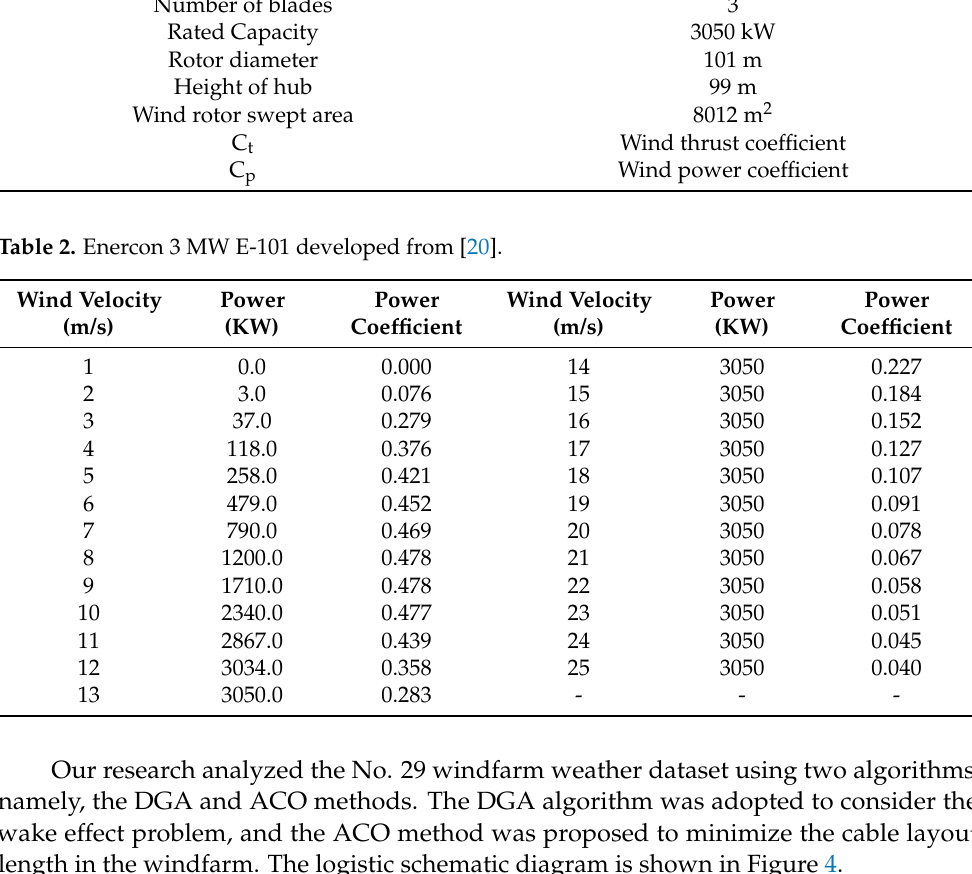
Table 1. Enercon E-101 3 MW unit parameters developed from [11,20].